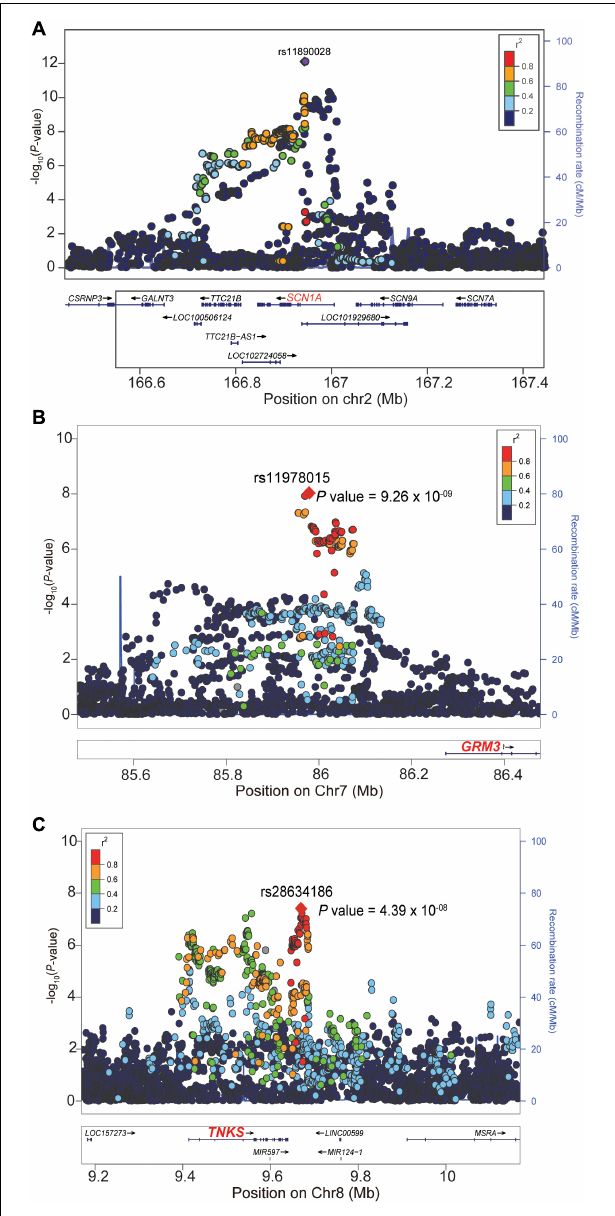
FIGURE 2 | Locuszoom plots of the three genome-wide significant (GWS) loci. (A) The lead SNP rs11890028 ( P = 7.76 × 10 - 13 ) of the 2q24.3 risk locus resides in intronic region of SCN1A . (B) The lead SNP rs11978015 ( P = 9.26 × 10 - 9 ) of the 7q21.11 risk locus resides upstream of GRM3 . (C) The nearest gene for the lead SNP rs28634186 ( P = 4.39 × 10 - 8 ) on the 8p23.1 is TNKS . The read dotted line represents the genome-wide significance level (5.0 × 10 - 8